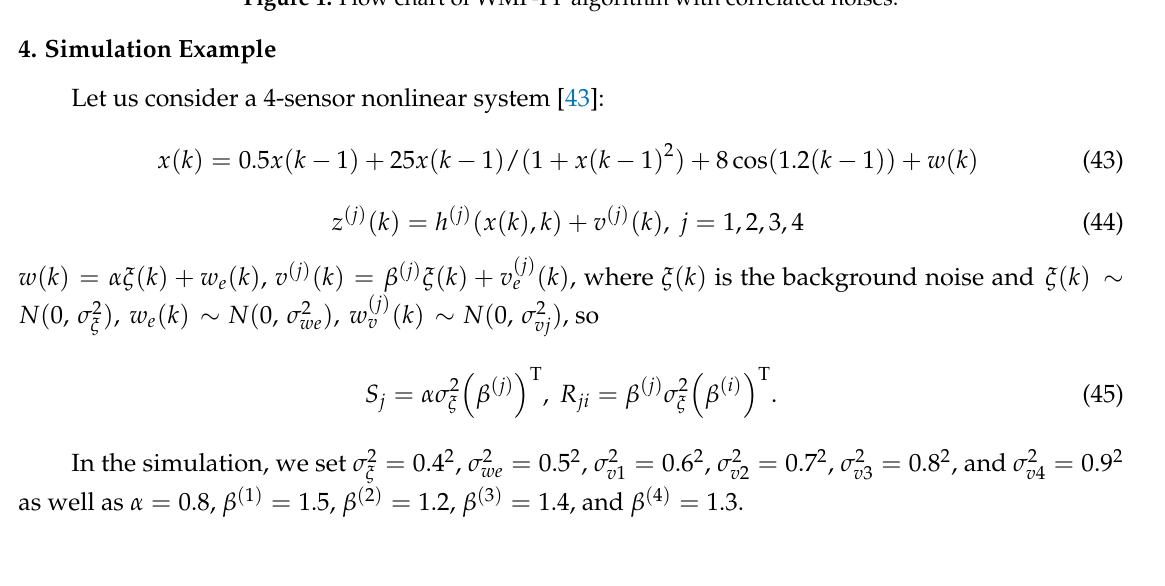
Figure 1. Flow chart of WMF-PF algorithm with correlated noises.